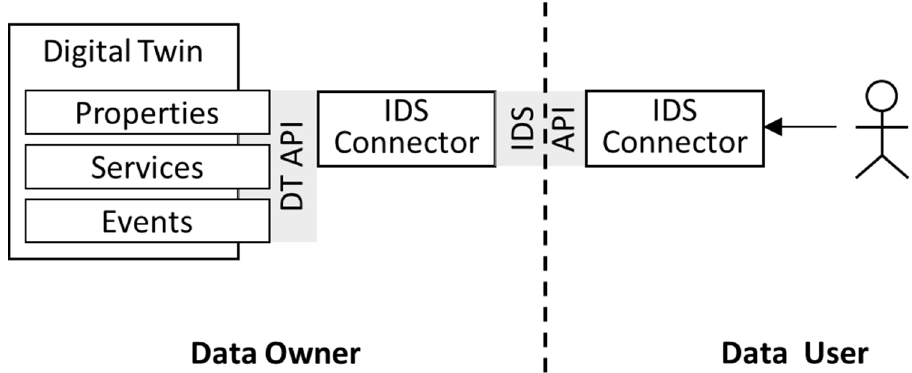
Figure 8. User interacting with an AAS-compliant DT protected via IDS.